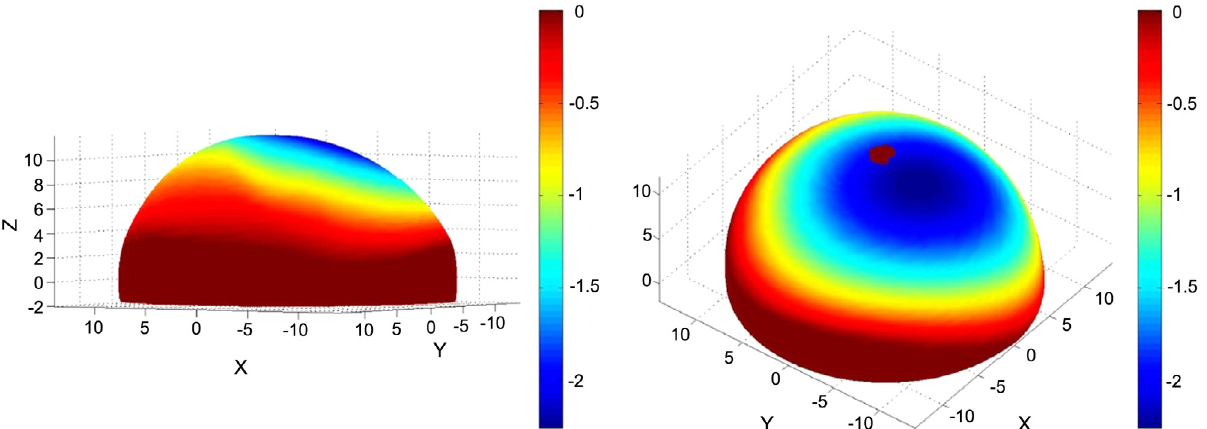
Figure 3. Wear map shows marked asymmetry of the retrieved ceramic femoral head. Red areas indicate unworn surface, blue areas represent maximum wear. Anterior surface to the right. Units in